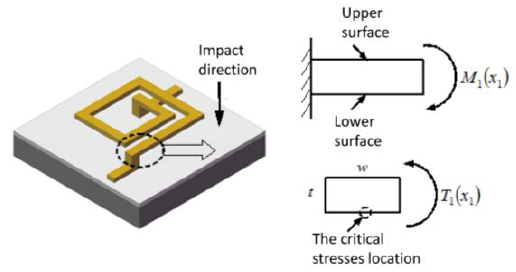
Figure 7. Critical stress location of the inductor coil.